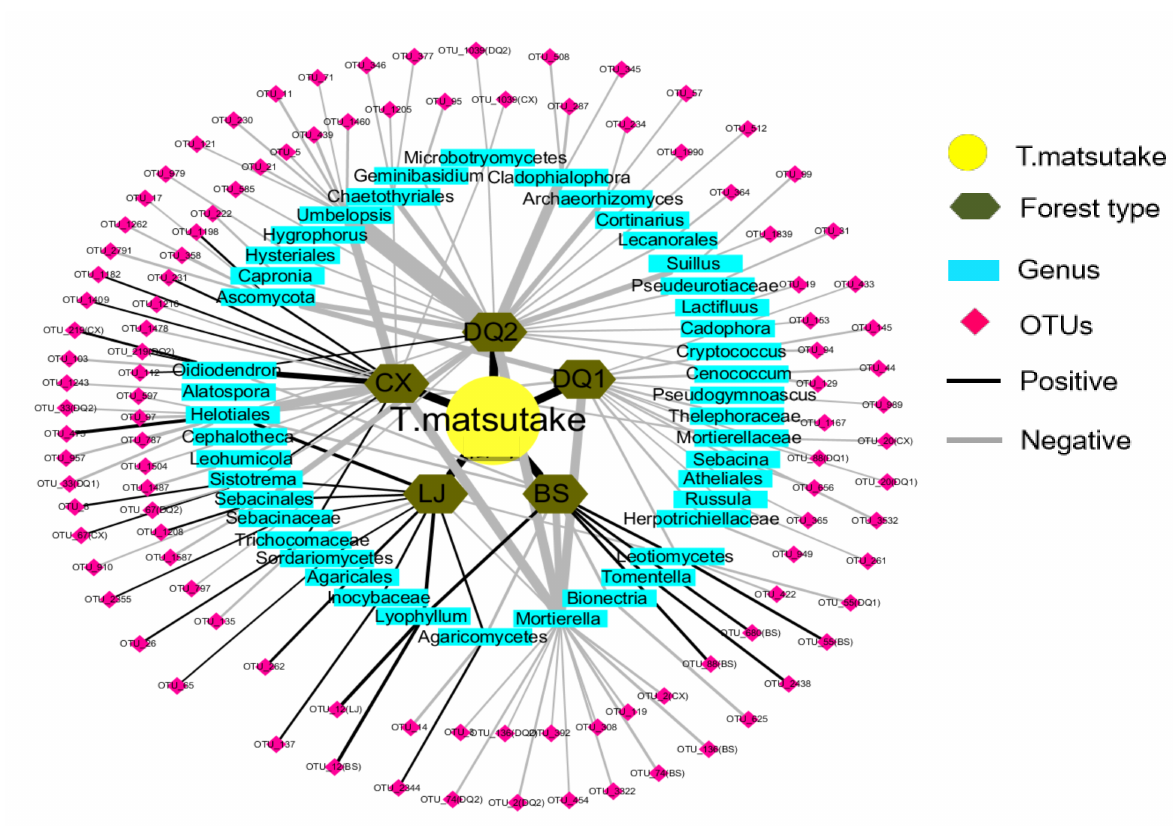
Figure 4. Correlation network of T.matsutake and other soil fungi in the shiro soil Figure 1. DQ2), Lijing (LJ), Baoshan (BS) and Chuxiong (CX) based on Spearman correlation analysis. The thickness of line indicates the R 2